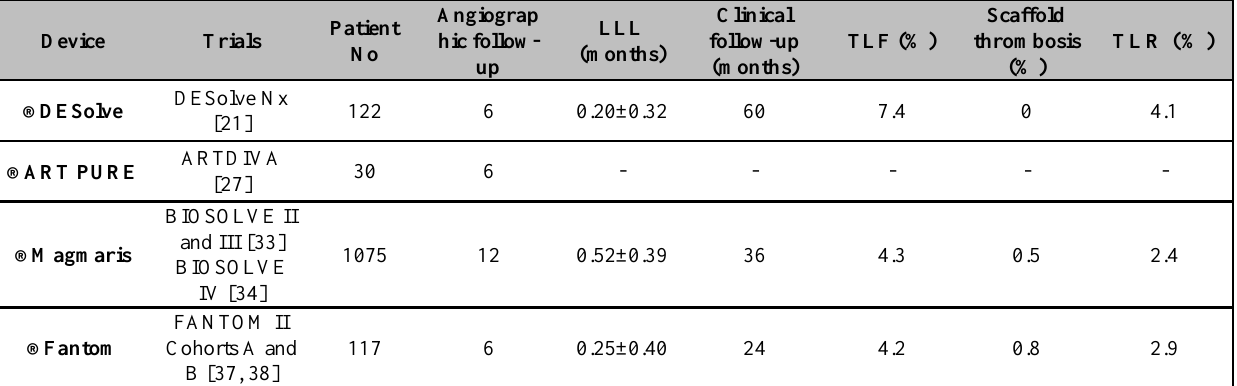
Table 2: Clinical performance measures of ®DESolve, ®ART Pure, ®Magmaris, and ®Fantom BRS devices